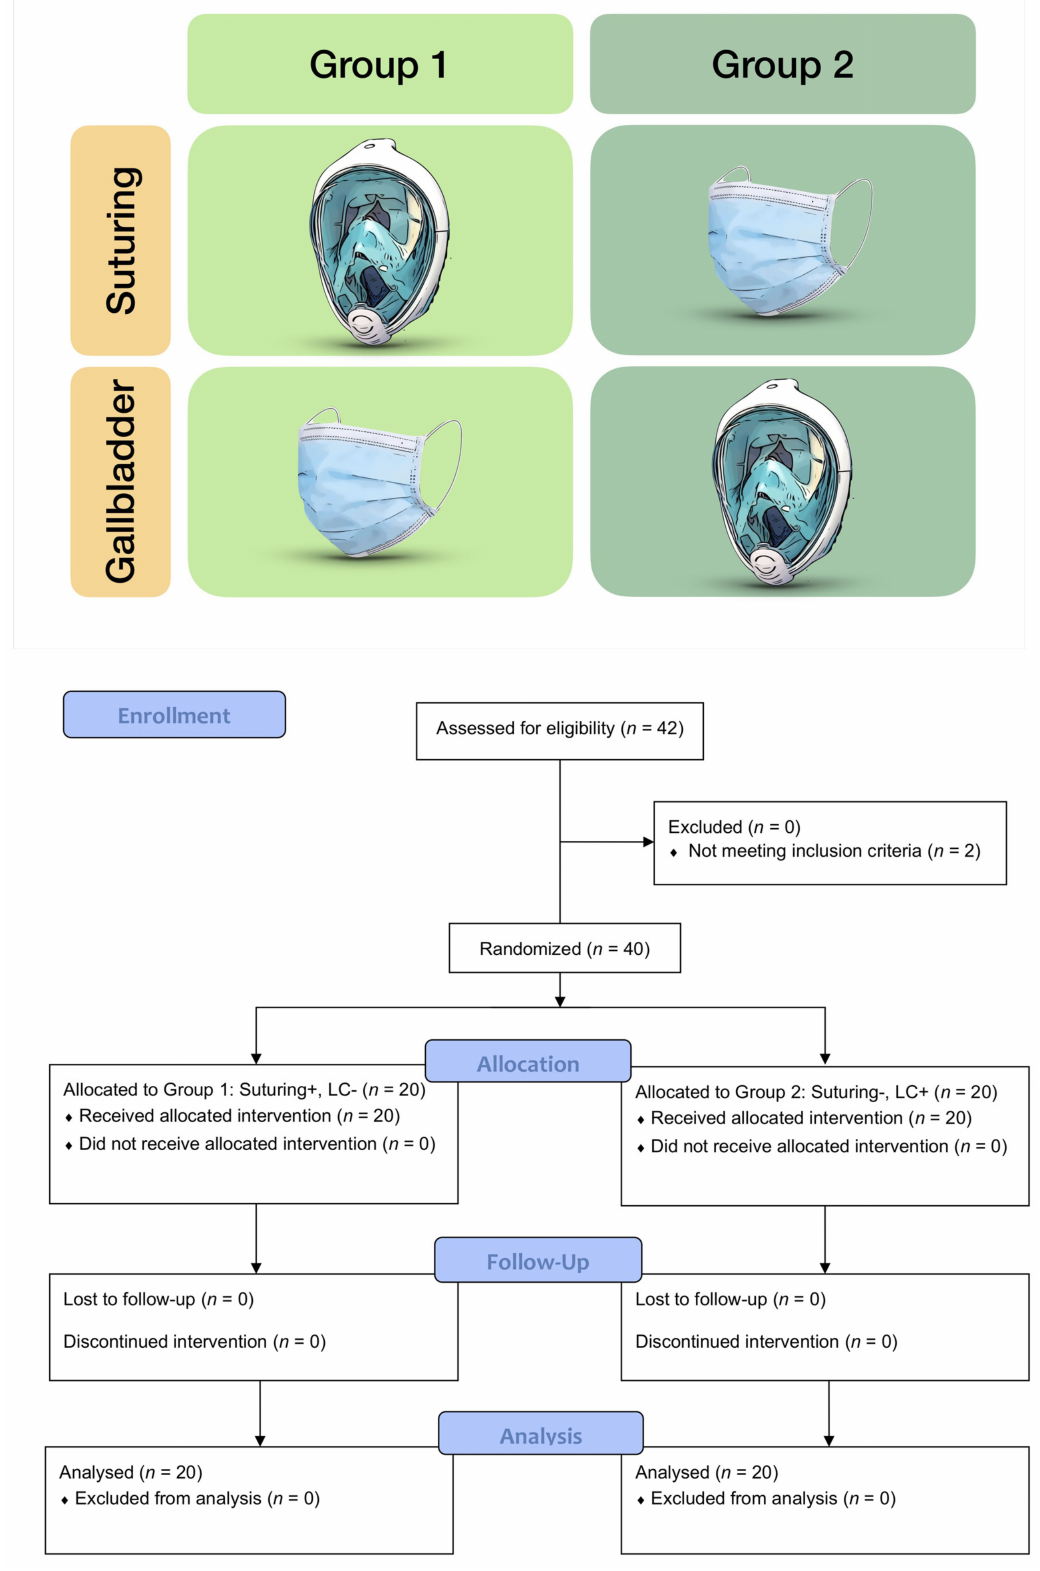
Figure 2. Study design and CONSORT 2010 flow diagram. Group 1 performed the suturing task while wearing the full-face diving mask (+), whereas Group 2 was wearing the surgical mask ( − ). For cholecystectomy, the masks were